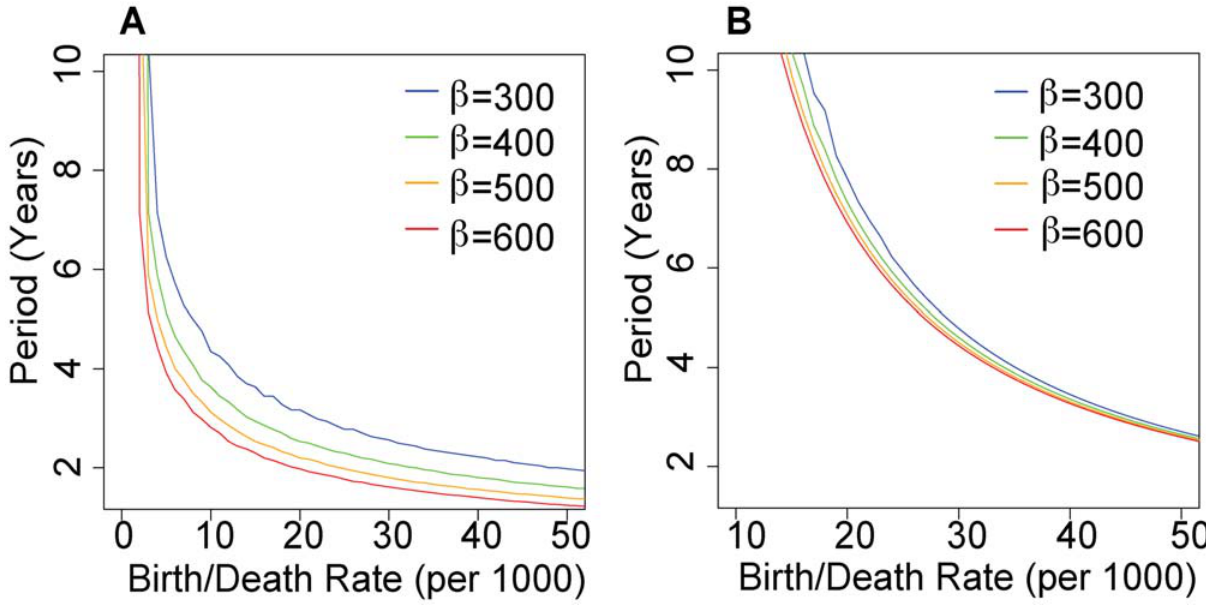
Figure 6. Period of multiannual oscillations of a four-serotype dengue transmission model. (A) Simulations include immune enhancement of transmission (second infections are 1.85 times as transmissible as primary infections) [17]. (B) Simulations including no immune enhancement but including seasonality in transmission coefficient (peak coefficients exceed mean coefficients by 4%). Period is plotted as a function of birth/death rate for simulations in which the transmission coefficient, b is 300 (blue), 400 (green), 500 (orange), and 600